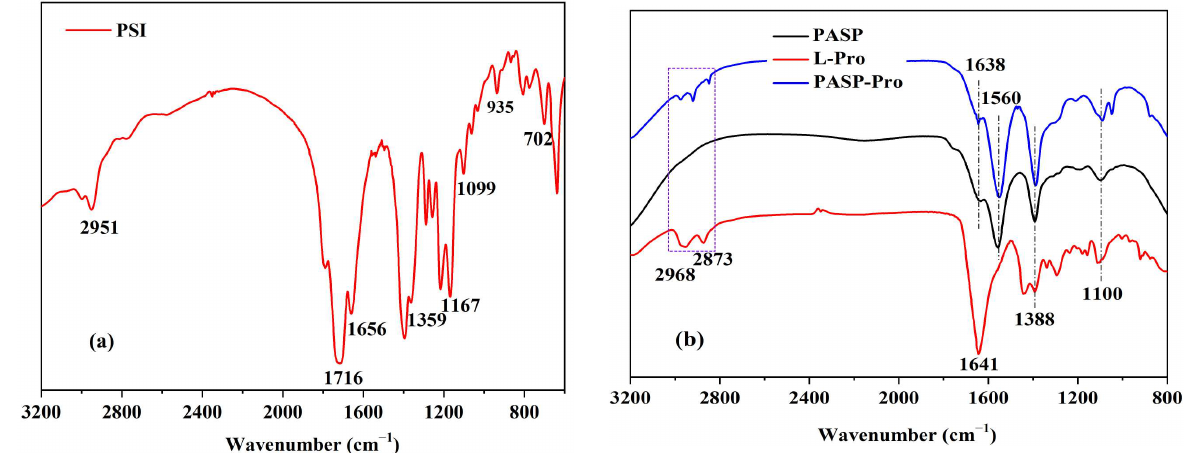
Figure 2. FTIR spectra of PSI, L-Pro, PASP, and PASP-Pro on the synthetic route. PSI ( a ); L-Pro, PASP, and PASP-Pro ( b ).